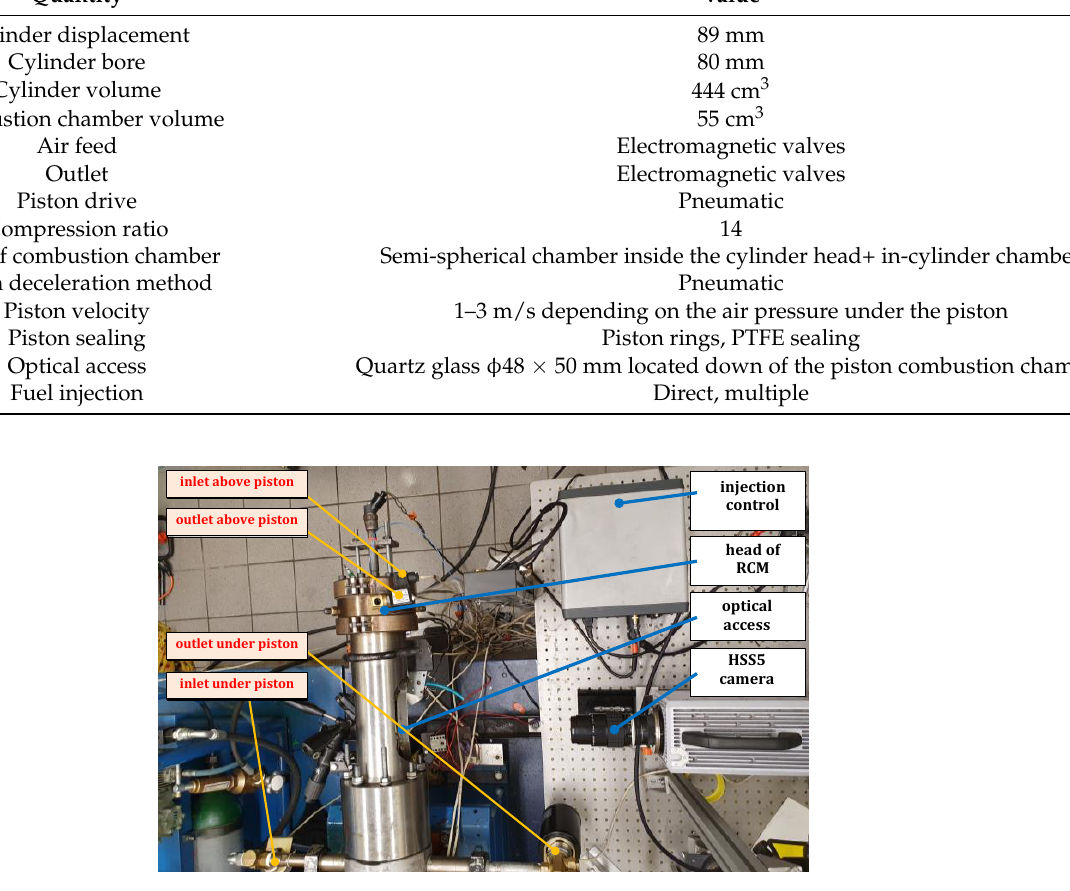
Figure 4. Four tracings have been shown of the electromagnetic valves controlling the air camera synchronization.